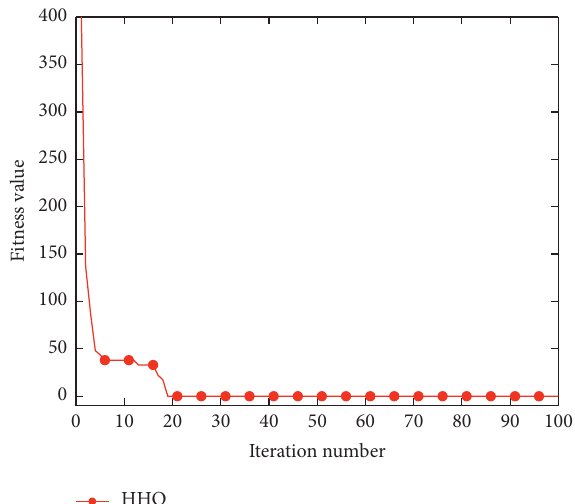
Figure 9: The evolution curve of fitness